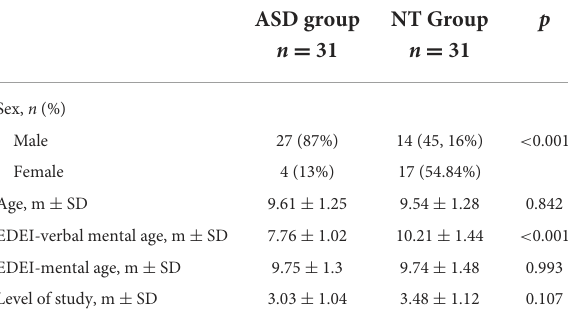
TABLE 1 General characteristics of the autism spectrum disorder group vs. the neurotypical group.